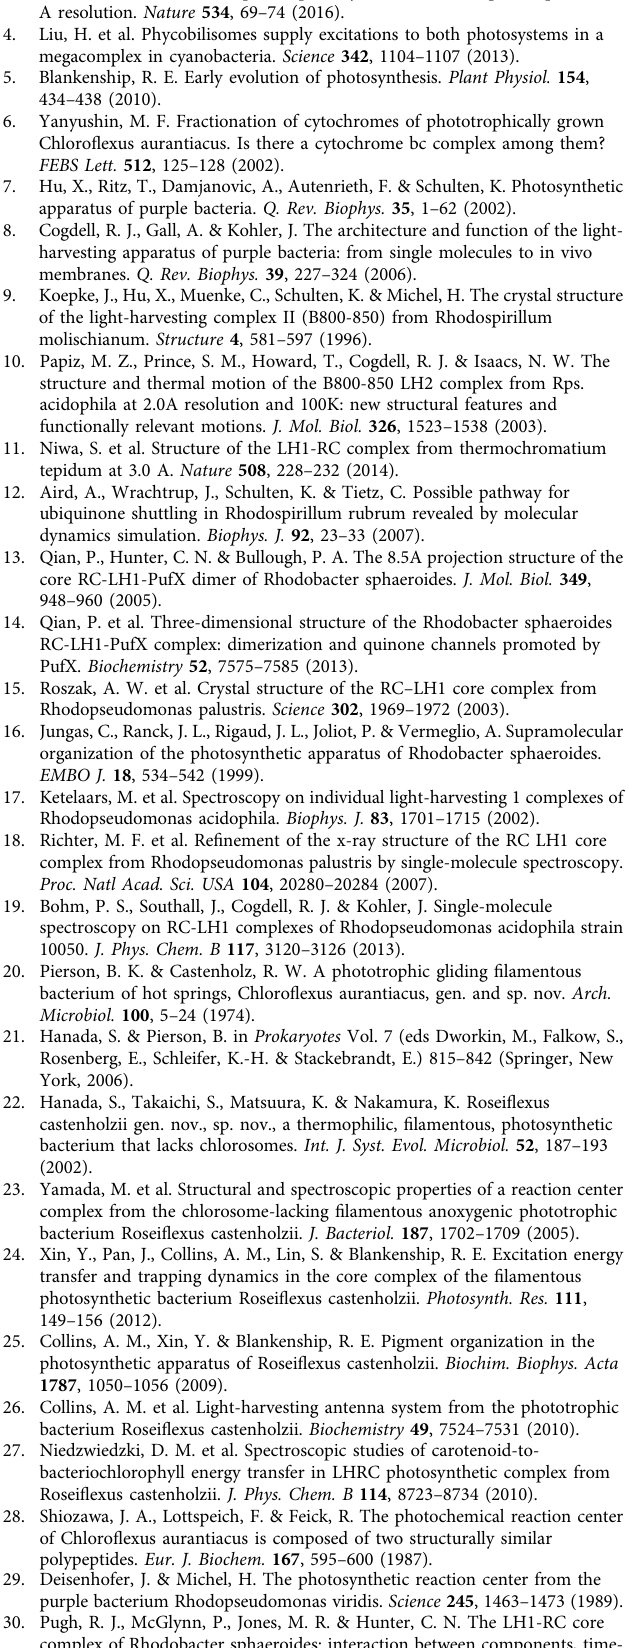
N-terminal protein sequencing . The puri fi ed rc RC – LH complex was separated on a 16% Tricine SDS-PAGE gel 54 . The running conditions were 30V for 1h followed by 150 V for 5 h. The gel was transferred onto a polyvinylidene di fl uoride (PVDF) membrane by electrophoresis at 6V for 18h at 4°C. The bands of Cyt c , L, and M subunits were excised manually from the membrane, and then were used for N- terminal sequencing by Edman degradation, which was performed using PRO- CISE491 Sequencer (Applied